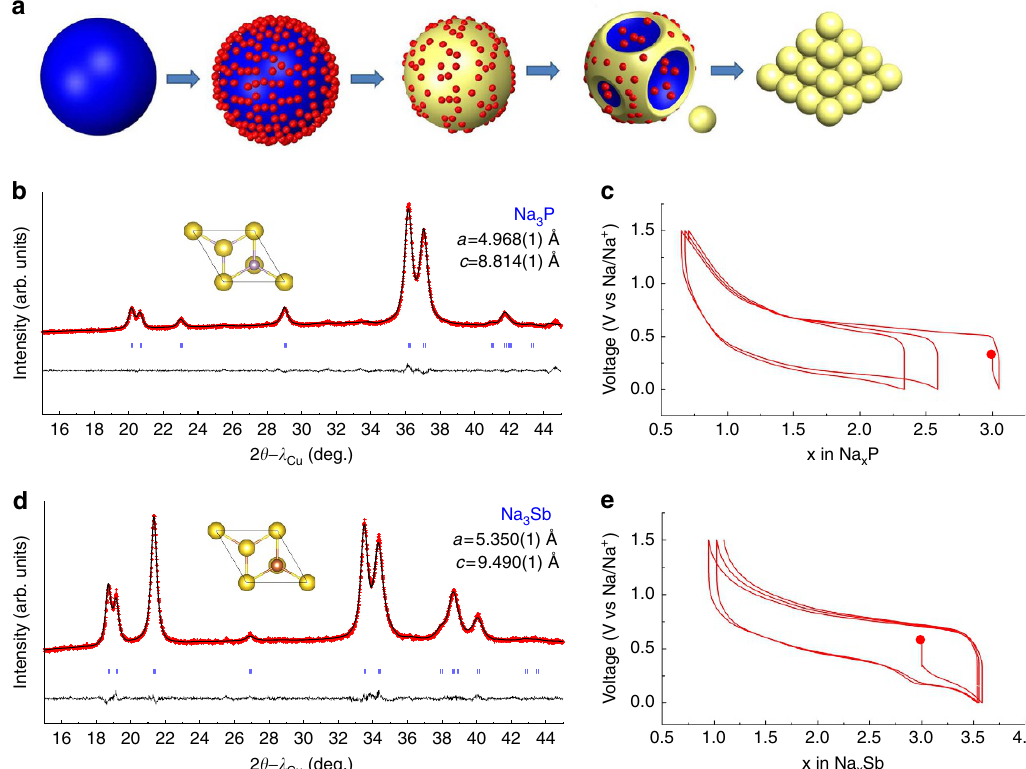
Figure 1 | Synthesis of Na-based alloys. ( a ) Schematic diagram showing the ball milling process exemplified for the formation of Na x M alloys (yellow) by reacting Na (blue) with metal M (M ¼ P or Sb) (red). In b , c and d , e , the Rietveld refined X-ray powder patterns of Na 3 P and Na 3 Sb powders are respectively shown together with their corresponding electrochemical voltage-profile in Na-half cells. NATURE COMMUNICATIONS|7:10308|DOI: